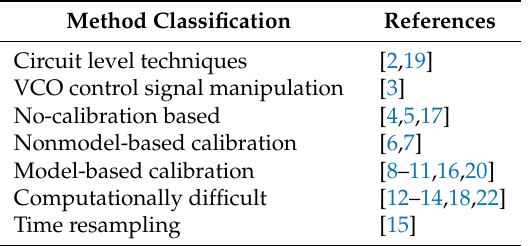
Table 1. Some of the known nonlinearity correction